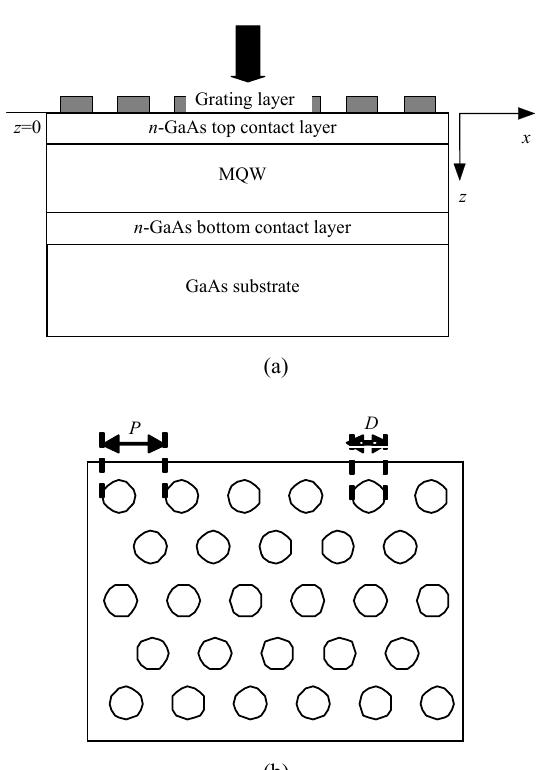
Fig. 1 Modelling structure of VLWIR QWIP: (a) device structure and coordinate direction and (b) structure of periodic hole